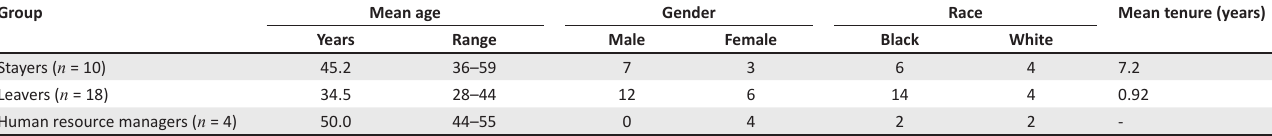
TABLE 2: Sample demographics.